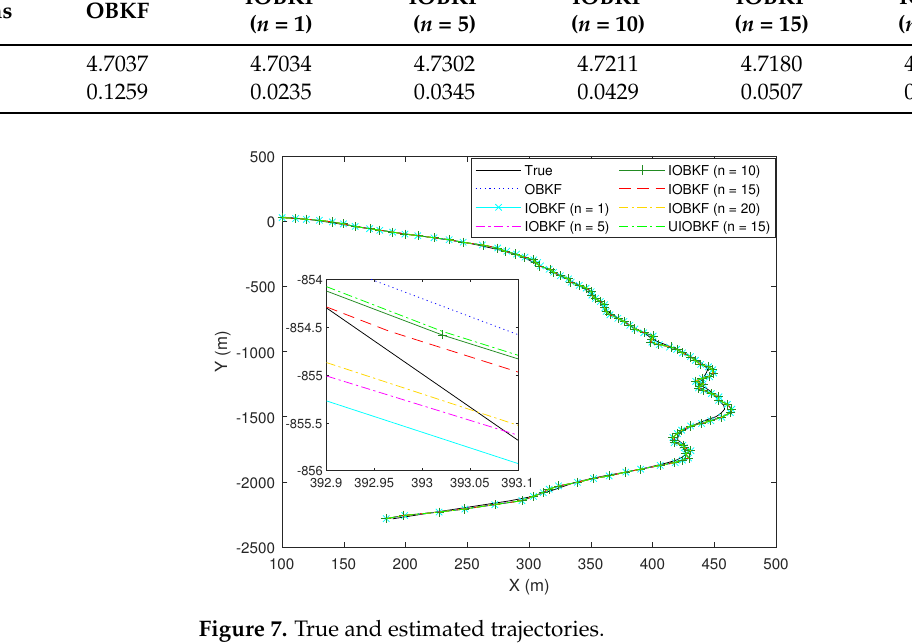
Figure 7. True and estimated